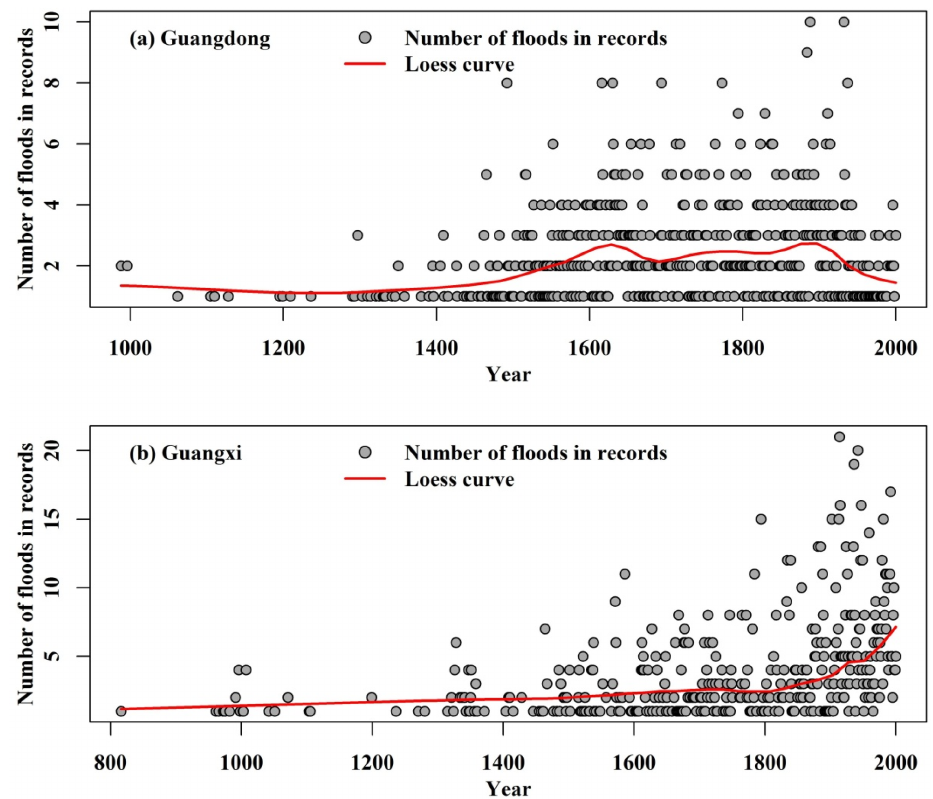
Figure 9. Temporal changes in occurrence rates of flood hazards of the past 1000 years in Guangdong (a) and Guangxi provinces (b)